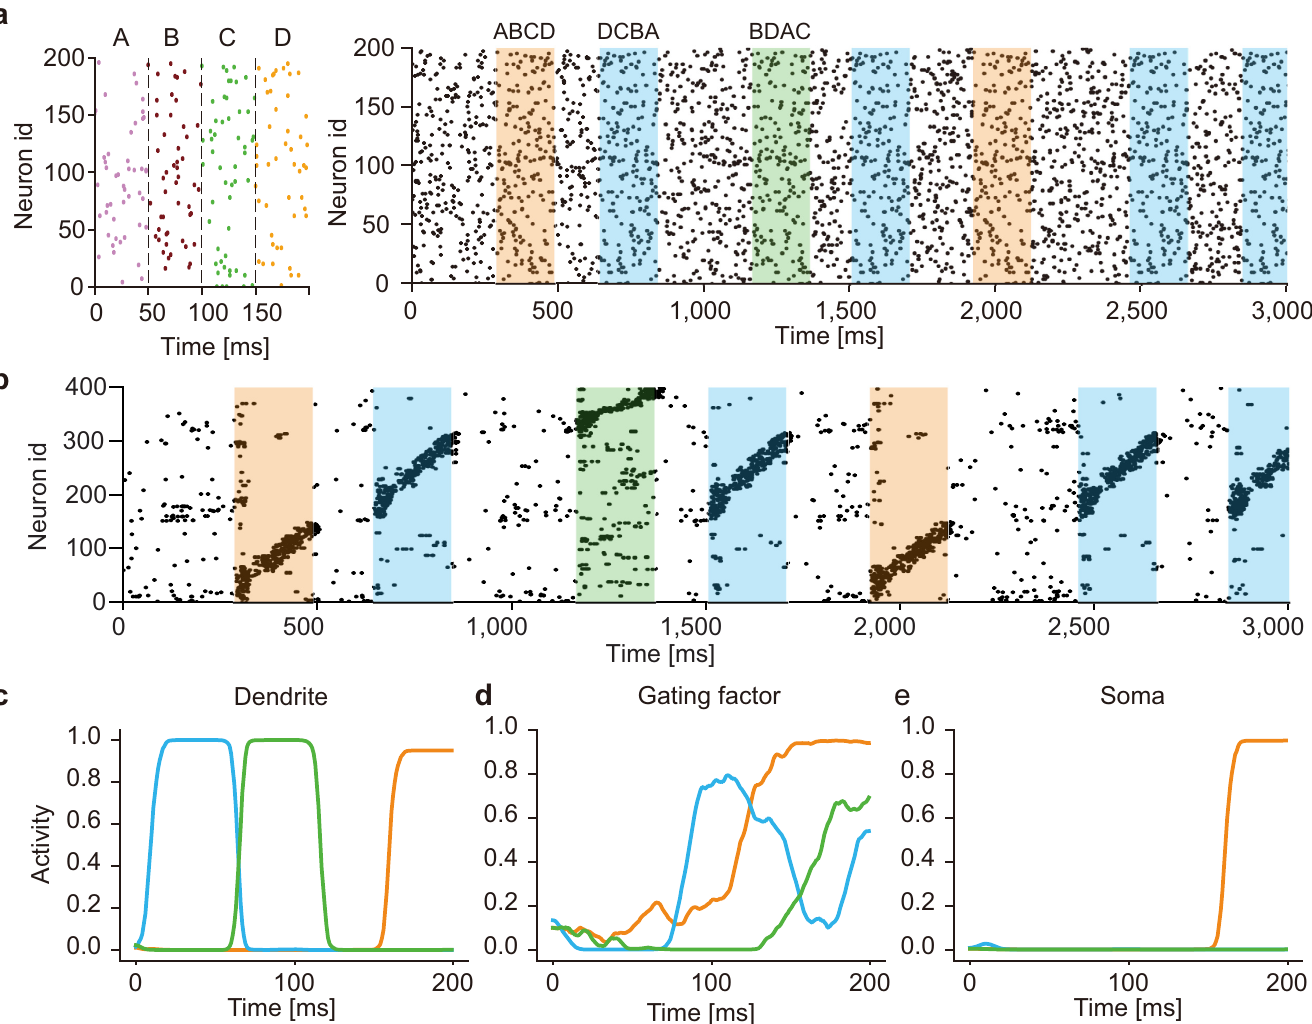
Fig 3. Learning of complex spike sequences with recurrent gating. (a) Three chunks were presented, which consists of four identical component patterns with its specific order (left). The example input spike train during first three seconds are shown (right). The regions filled in orange, blue and green represent the times when chunks "ABCD", "DCBA" and "BDAC" were presented, respectively. All neurons generate Poisson spike with the constant firing rate of 5Hz. Random spike sequences were presented in the unshaded areas. (b) Output spike trains of the trained network are shown. Neurons were sorted according to their onset response times, and only 400 out of 1200 neurons are shown for the visualization purpose. (c-e) The time evolution of dendritic activity, gating factor, and somatic response are shown in a neuron. Orange, blue and green traces represent the responses to its preferred component pattern "D" when the corresponding chunks were presented. The activities were averaged over 20